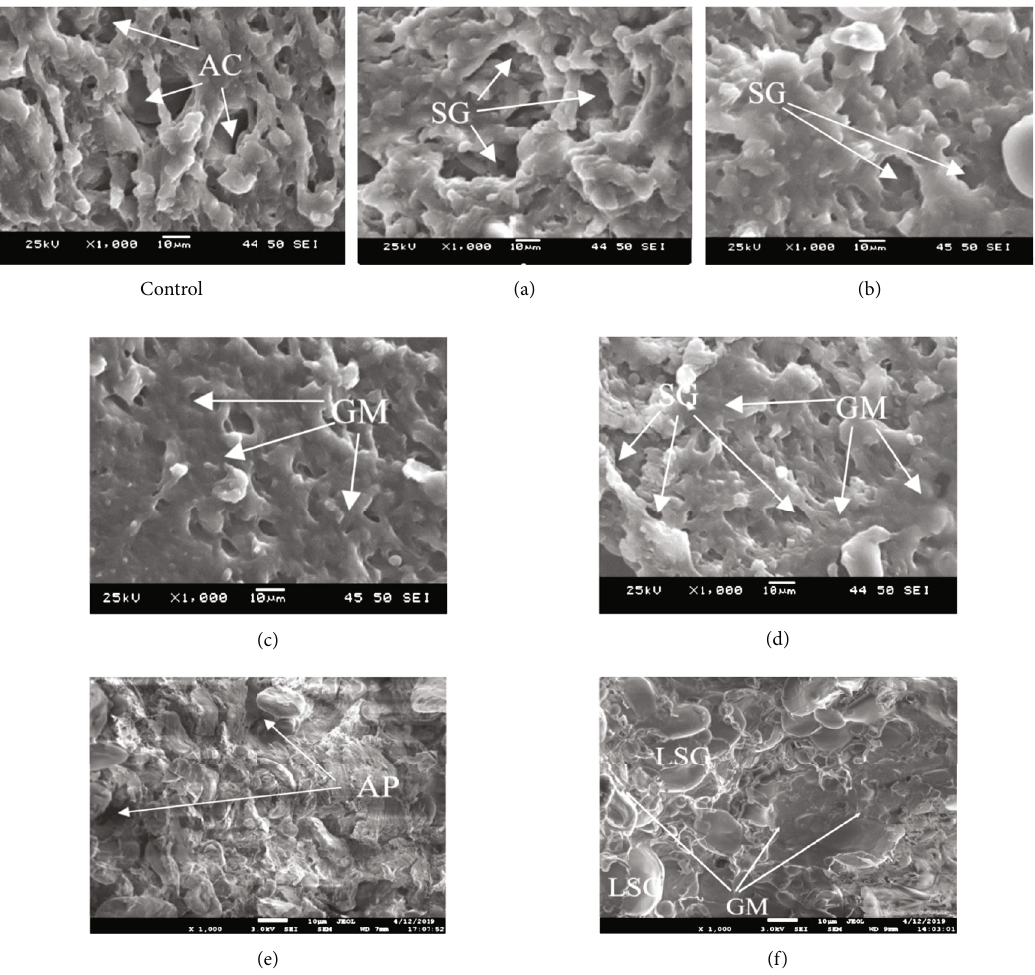
Figure 7: The microstructure of the bread crumb after 72 hours storage: GM: gluten matrix; AC: air cavity; AP: air